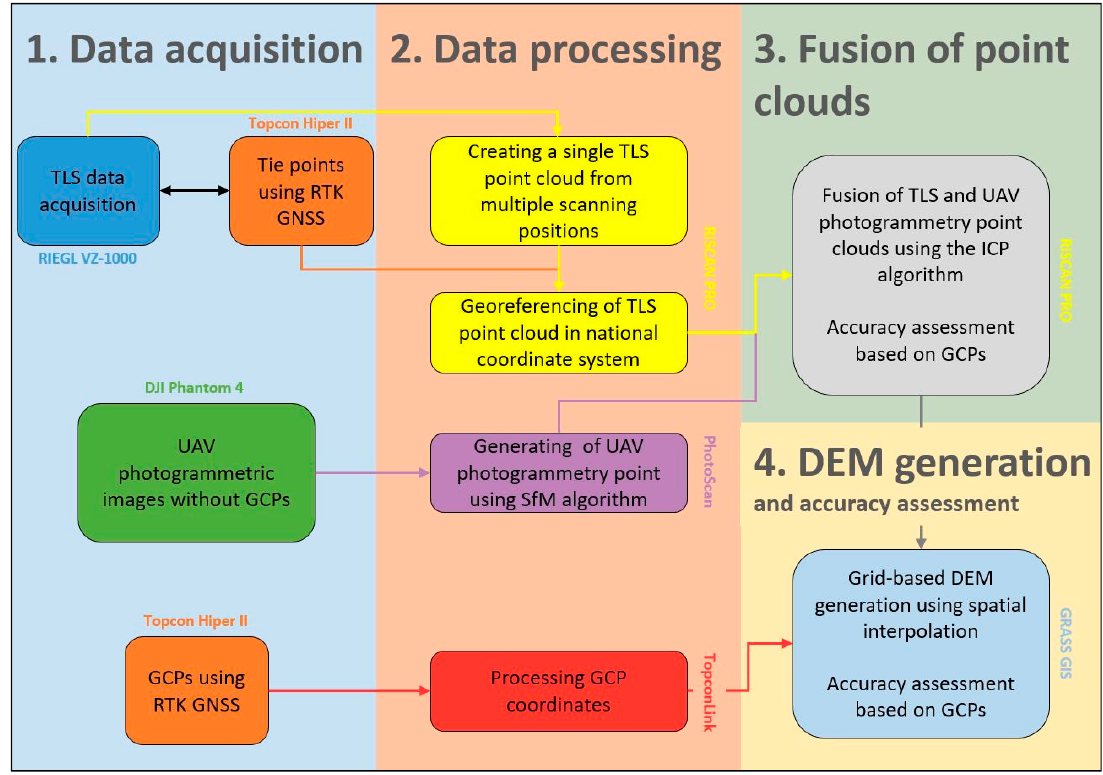
Figure 7. Schematic workflow of the combined use of TLS and UAV-SfM photogrammetry in mapping the rugged alpine topography including the notations of sensors, surveying tools, and software.